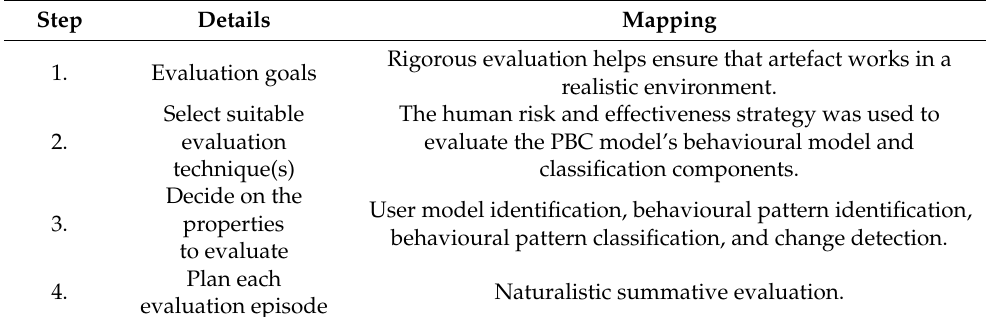
Table 1. Evaluation